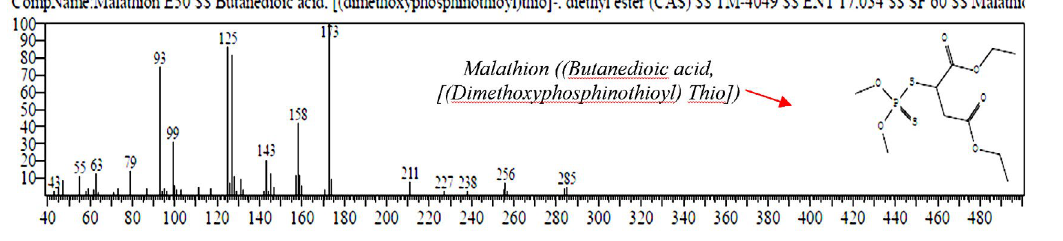
Fig. 5. The chromatogram of the chemical compound Malathion (C ((dimethoxyphosphinothioyl) thio) -, monoethyl ester